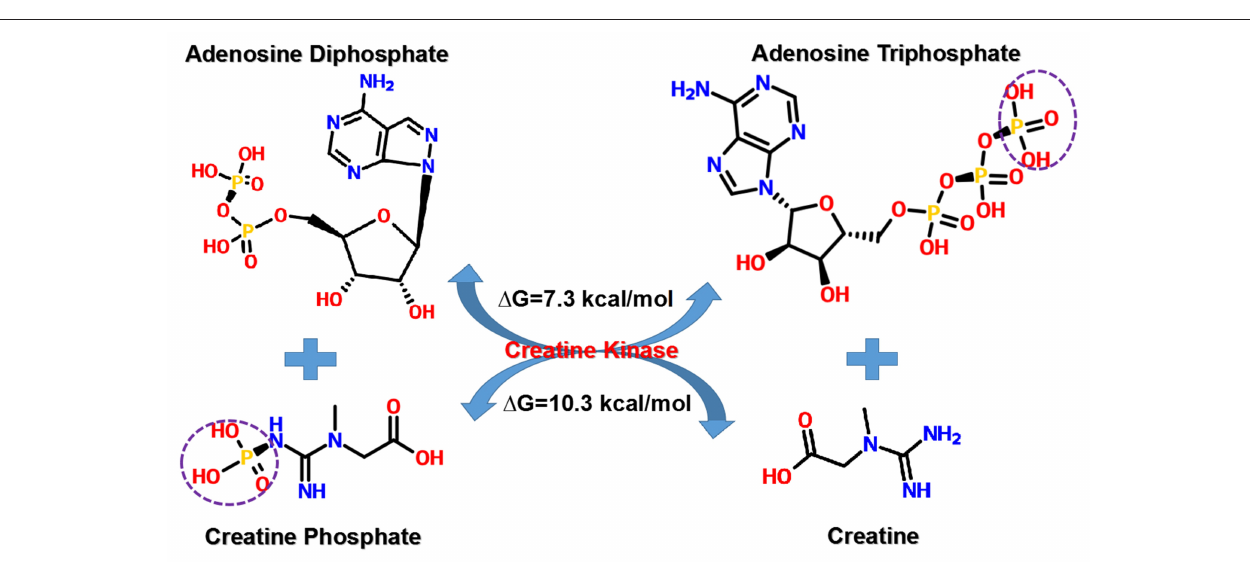
FIGURE 2 | Transfer of HEP-bond through “CrP shuttle.” There is one HEP-bond (N ∼ P) in the chemical structure of CrP. As compared, ATP has a relatively more complex molecular structure and two HEP-bonds (O ∼ P). However, the N ∼ P bond of CrP has more energy than either one O ∼ P bond of ATP, 10.3 kcal/mol in comparison with 7.3 kcal/mol. ATP, adenosine triphosphate; CrP, creatine phosphate; HEP, high-energy phosphate; 1 G, Gibbs free energy change.